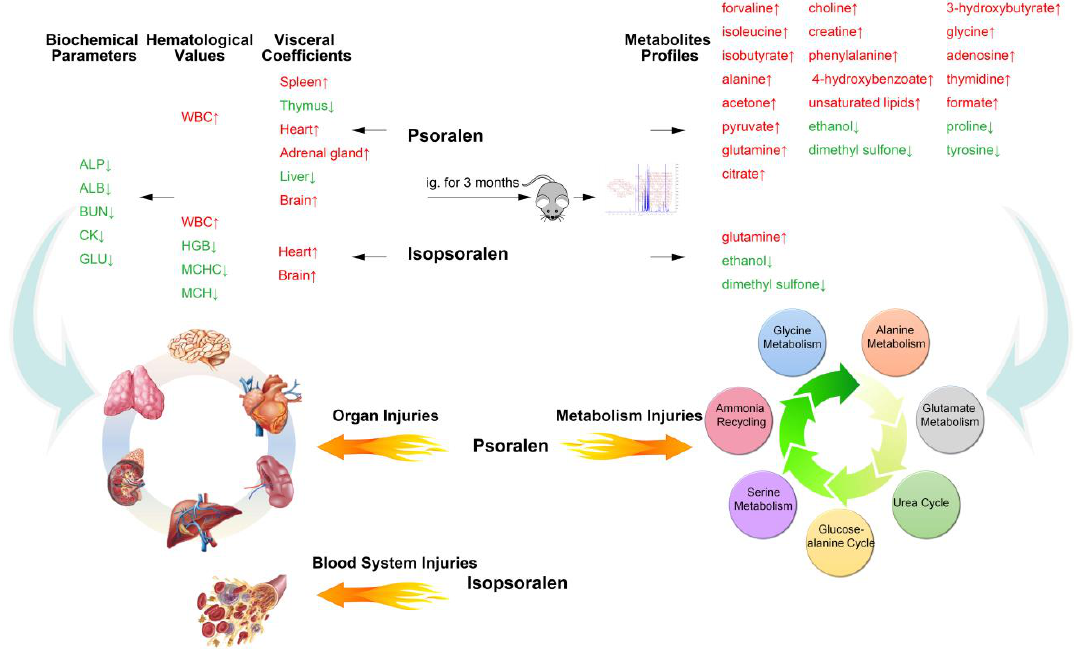
Figure 7. Schematic diagram illustrating the hepatotoxic effect of psoralen and isopsoralen on rats.